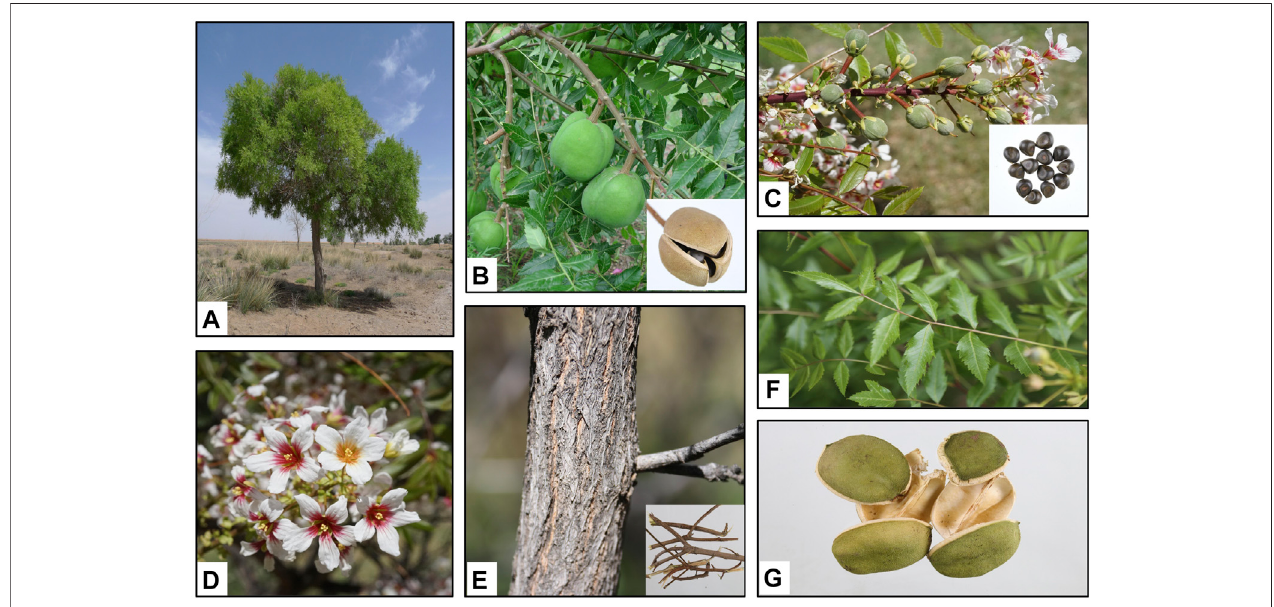
FIGURE 1 | Xanthoceras sorbifolium Bunge. (A) . Whole plant; (B) . Fruits; (C) . Seeds; (D) . Flowers; (E) . Wood (The thunks and branches); (F) . Leaves; (G) . Husks.